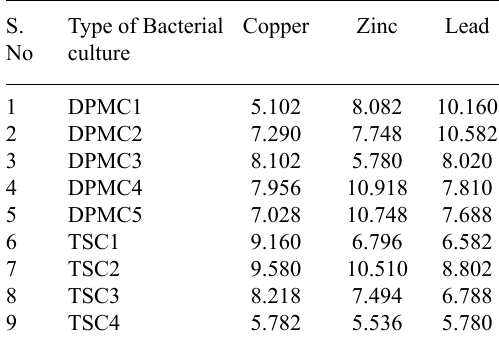
table 6. In vitro Application Report